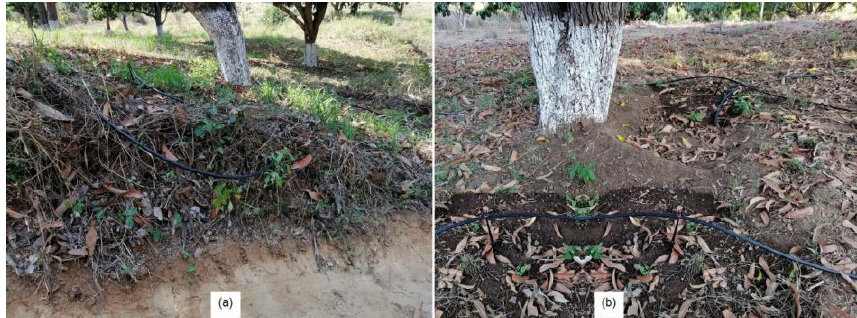
Figure 5. Water moisture ( a ) absorbed by the soil and, ( b ) around the mature tree.